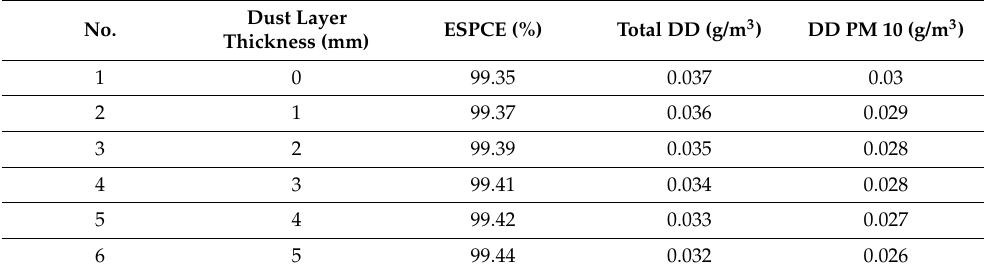
Table 11. Dust resistivity is 10 12 Ω × cm, when the thickness of the dust layers on the collecting surfaces is the same and the sections are not rapping.